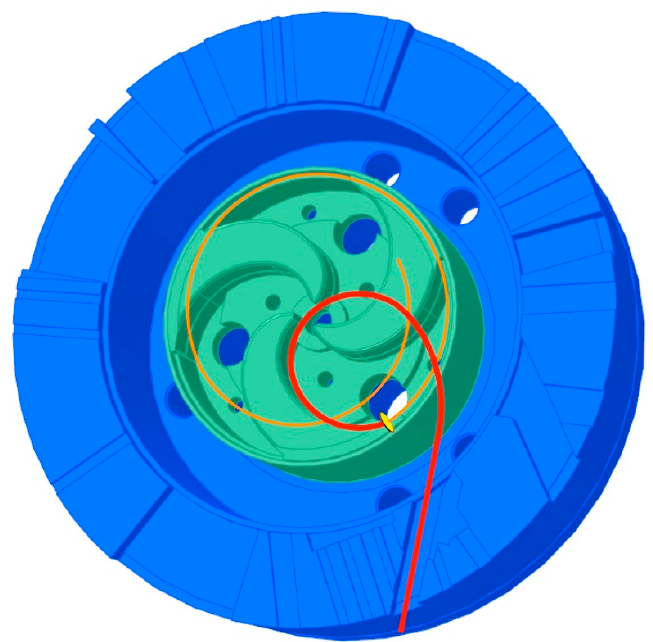
Figure 1. Pictorial sketch of the inner part of the upgraded cyclotron with the stripper foil and an example of trajectory for an accelerated ion before (in orange) and after (in red) being stripped and extracted.